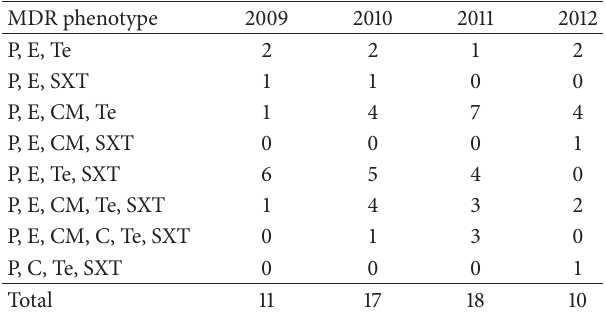
Table 4: MDR phenotypes of the 56 pneumococcal isolates by study